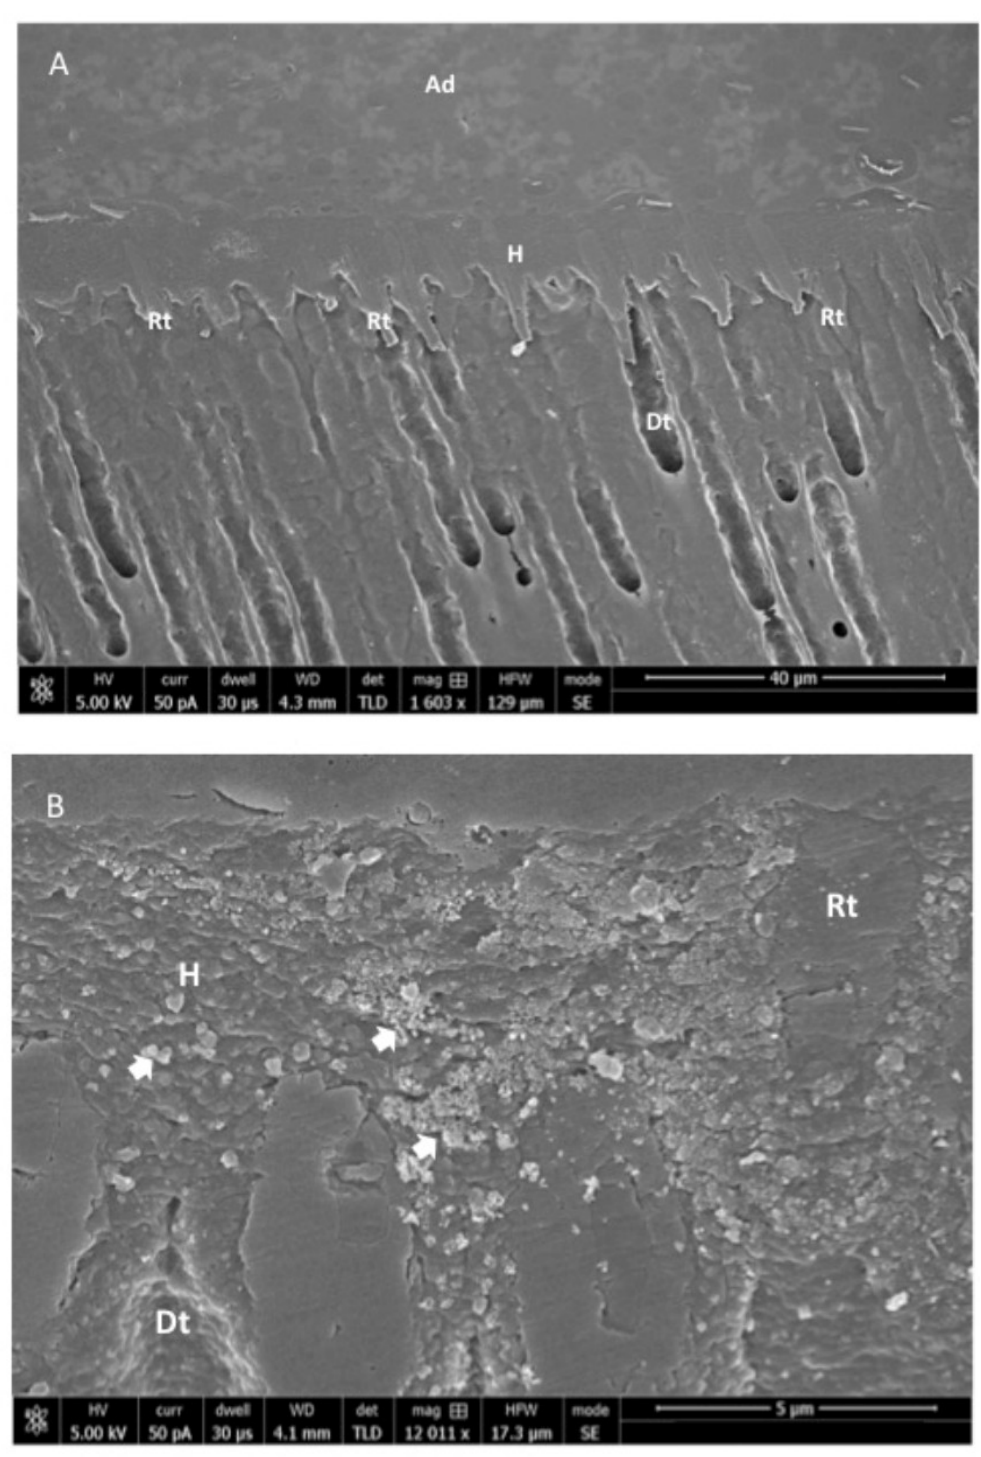
Figure 4. ( A ) Field emission scanning electron microscopic (FE-SEM) micrograph of resin-bonded sample showing the formation of a hybrid layer and integration between dentin and modified experimental gp-2: 5 wt % n-HA (HAA-5%) adhesive. Ad: adhesive, H: hybrid layer, Rt: resin tags; Dt: Dentin tubule. ( B ) Magnified image of the hybrid layer showing widely distributed n-HA particles within the hybrid layer (HAA-5%). Ad: adhesive, H: hybrid layer, Rt: resin tags; Dt: Dentin